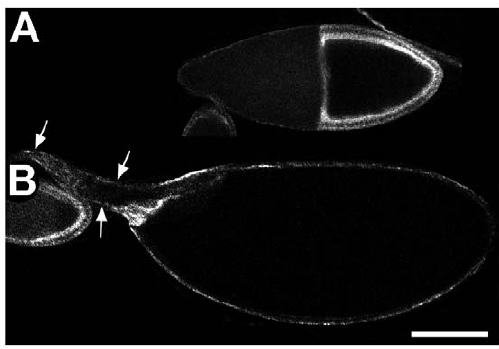
Figure 4. Liquid facets-related is required in the follicle cells for normal oogenesis. (A) Stage 10B and (B) stage 14 germline clone egg chambers stained with anti-LqfR H7666. Arrows show the dorsal appendages. Anterior is left. Dorsal is up in (B). Images are single confocal slices. Ovarioles are from flies with genotype w; pr pwn hsFLP/ + ; FRT-82B ovoD1-18/FRT-82B lqfR D66 . Bar, 100 m m.